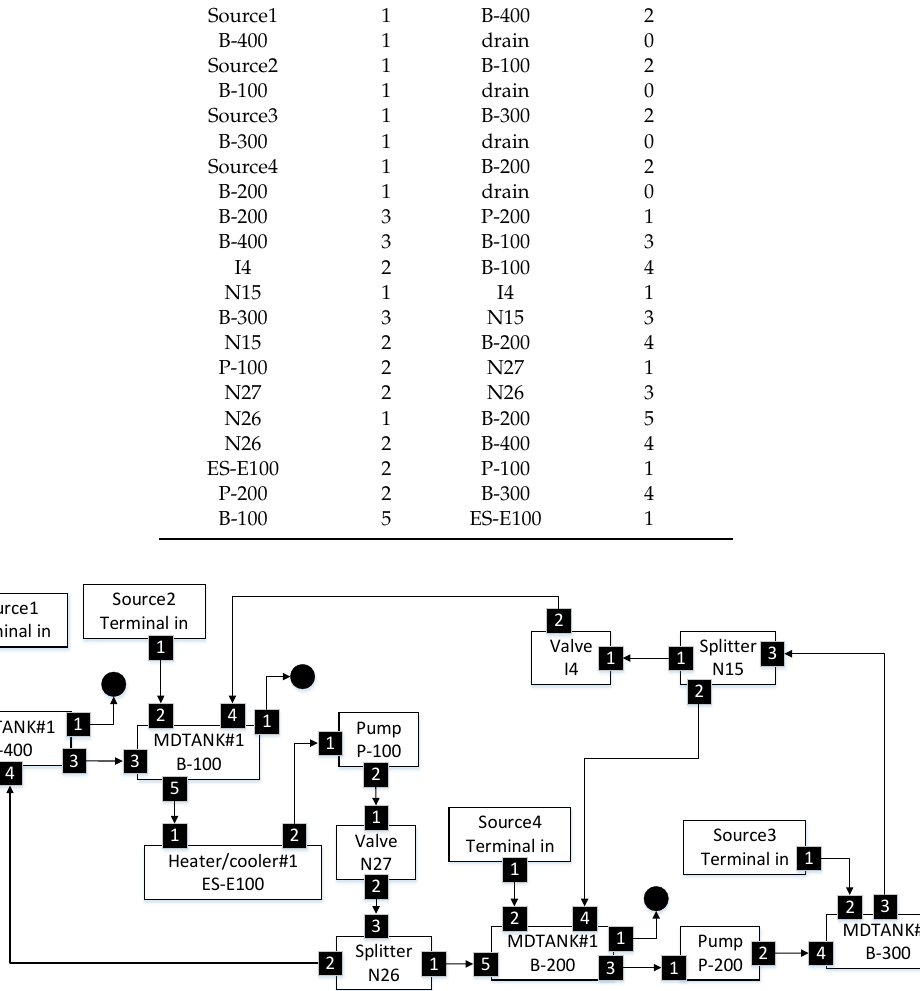
Figure 13. Visualization of the Balas® model specified in Table 2 and Table 3.